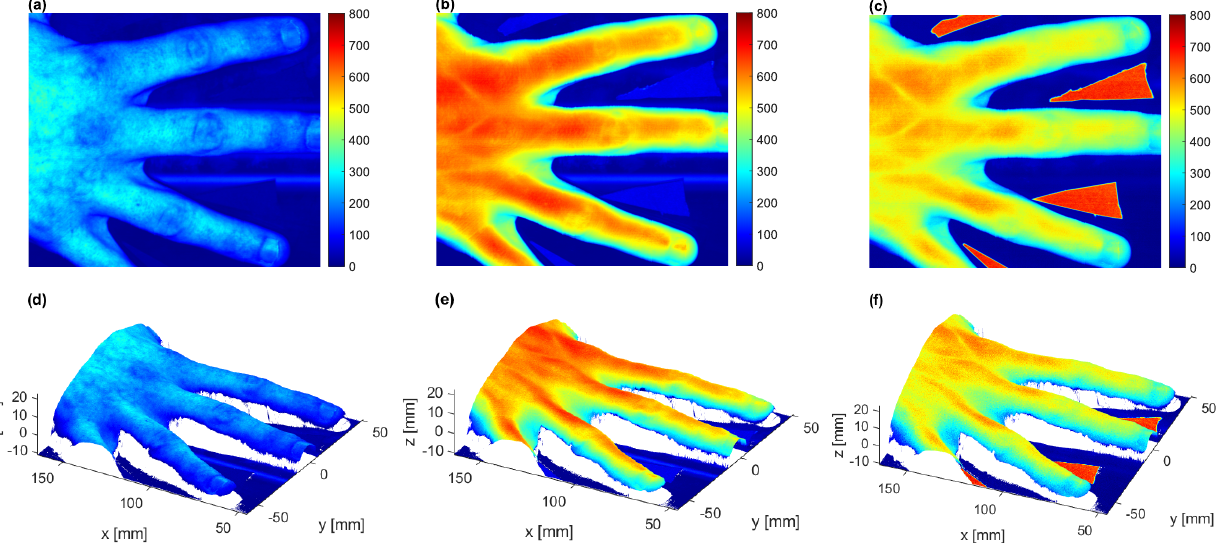
Figure 12. An example of utility of the custom-made laboratory hyperspectral imaging (HSI) system, where reflectance imaging and profilometry were simultaneously applied to a human hand. Raw hyperspectral images of a human hand at ( a ) 530 nm, ( b ) 770 nm, and ( c ) 930 nm with corresponding three-dimensional surface data: ( d ) 530 nm, ( e ) 770 nm, and ( f ) 930 nm are presented. The units are digital numbers. Profilometry measurements were aligned to the corresponding hyperspectral image. Information on hand thickness was collected at the pixel level. Integration time was 100 ms, FOV was 153 mm × 131 mm, with the entire imaging taking 210 s to acquire. The resolution of the hyperspectral image was 2448 × 2100, and resolution of profilometry was 0.17 mm in the scanning direction and 0.35 mm in the perpendicular